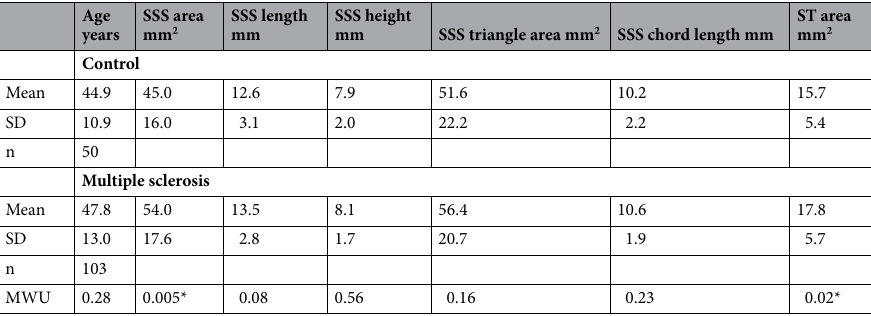
Table 1. Sagittal and straight sinus measurements. mm, millimeters; mm 2 , millimeters squared; MWU, Mann–Whitney U test; SD, standard deviation; SSS, superior sagittal sinus; ST, straight sinus. *Significance <